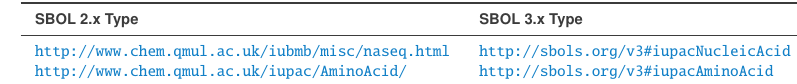
Table 17: Mapping of Sequence encoding values for IUPAC from SBOL2 to SBOL3